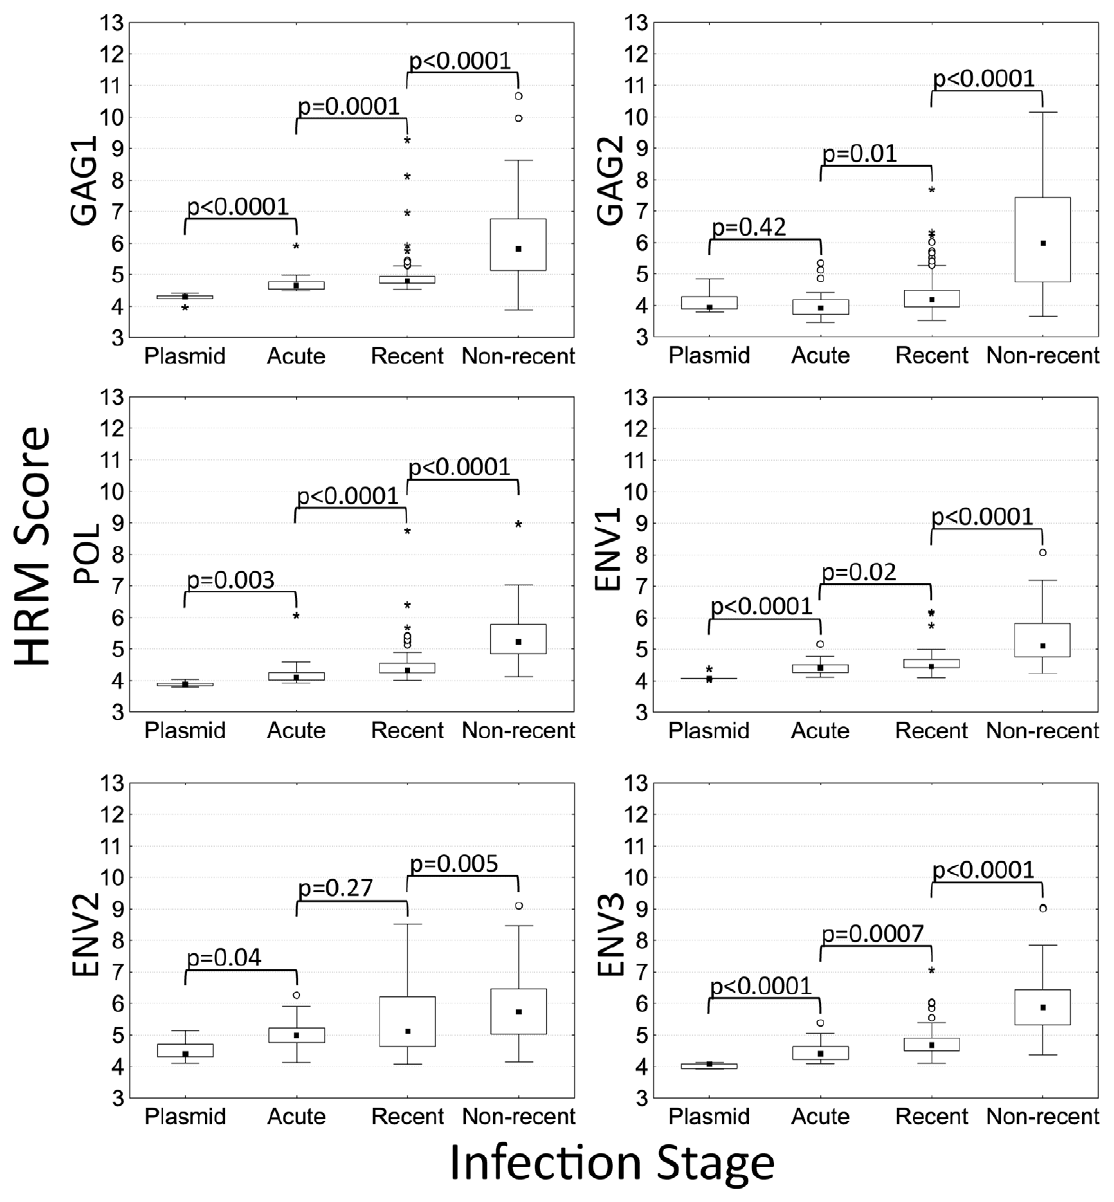
circle) and extremes (greater than [Q3] + [3 x IQR], asterisk) are shown.